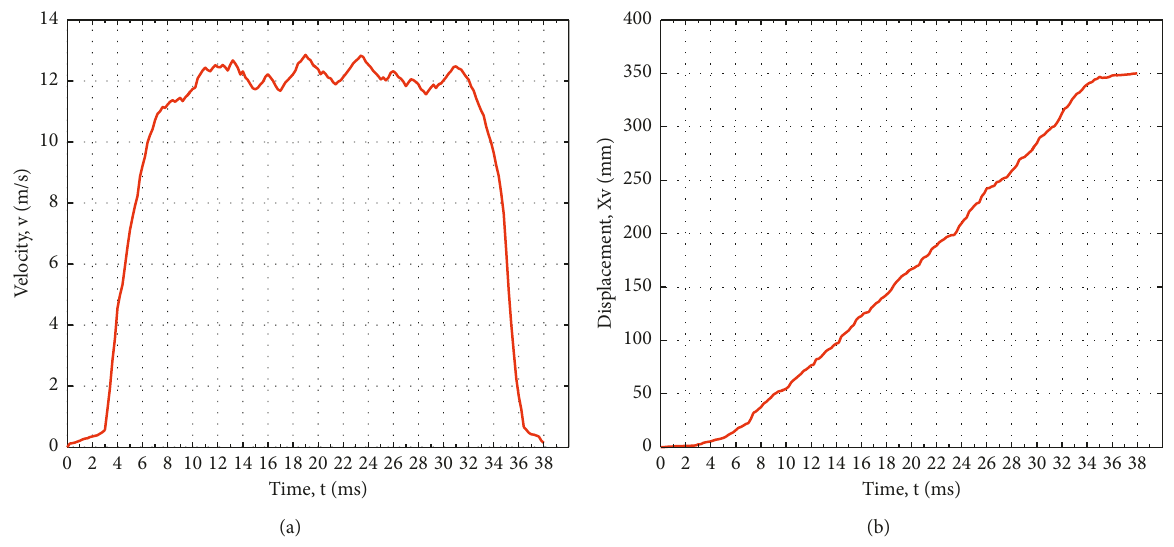
Figure 10: Experimental response curves of the impact rod. (a) Curve of measured impact velocity. (b) Curve of measured displacement of impact bar.